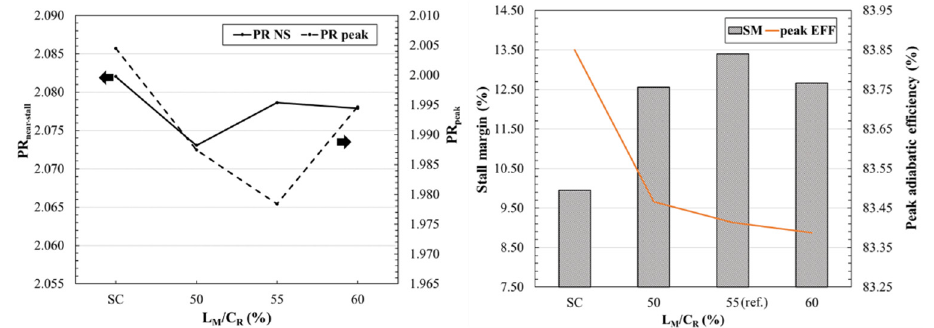
Figure 12. Effects of middle bleed location on performance.